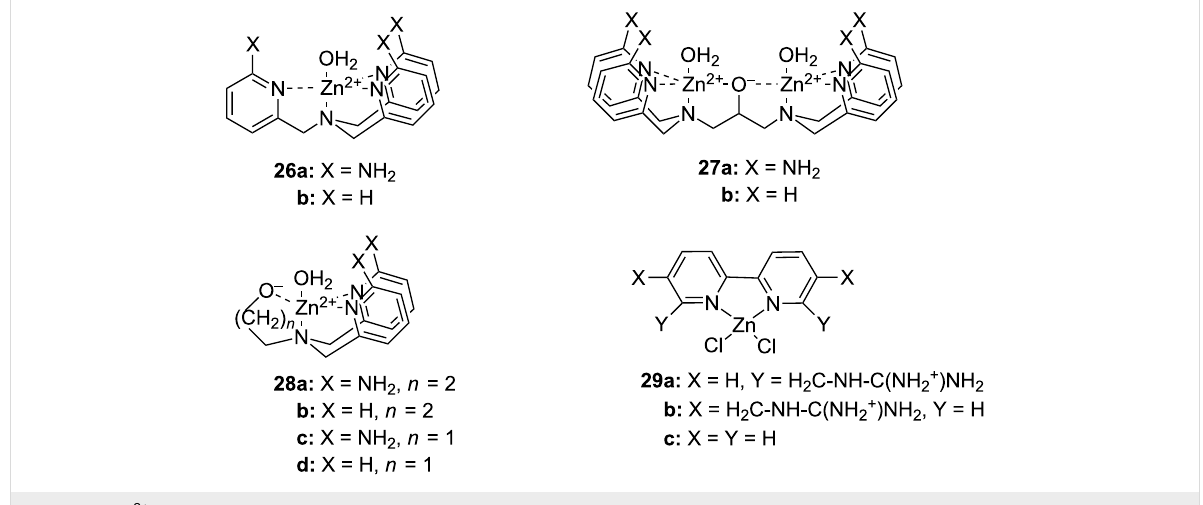
Figure 11: Zn 2+ -ion-based mono- and di-nuclear cleaving agents of nucleic acids.